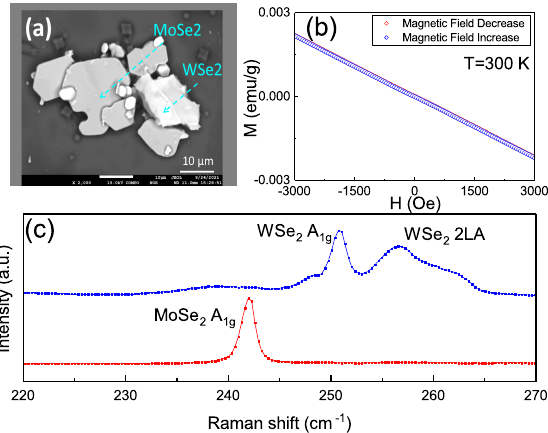
Figure 5. ( a ) The SEM image in the backscattering emission imaging mode. The light area is the WSe 2 and the dark area is the MoSe 2 . The sample was a mixture of WSe 2 and MoSe 2 flakes containing only one material within each flake. ( b ) The M–H curve shows the diamagnetism feature, and no hysteresis loops were detected. ( c ) The 242 cm − 1 for MoSe 2 , and 250 cm − 1 and 256 cm − 1 for WSe 2 , are shown in the Raman spectra. No mixed peaks or red-shifted peaks were